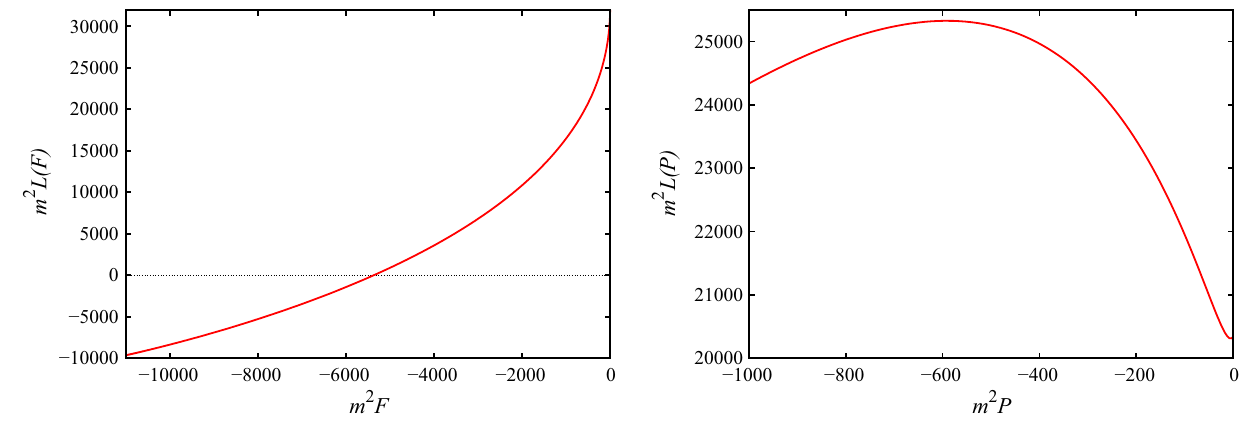
Fig. 13 Comparison between the f ( G ) no the linear case, mc 1 = 0, and the nonlinear, mc 1 = 2, generates by the Culetu solution and the f G ( G ) function for c 0 = 1 and q = 0 . 7 m